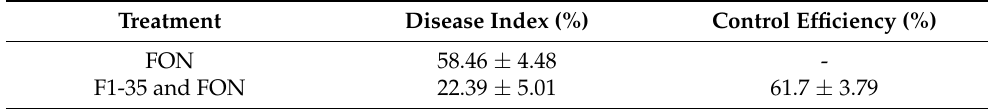
Table 1. Control efficiency of F1-35 on watermelon Fusarium